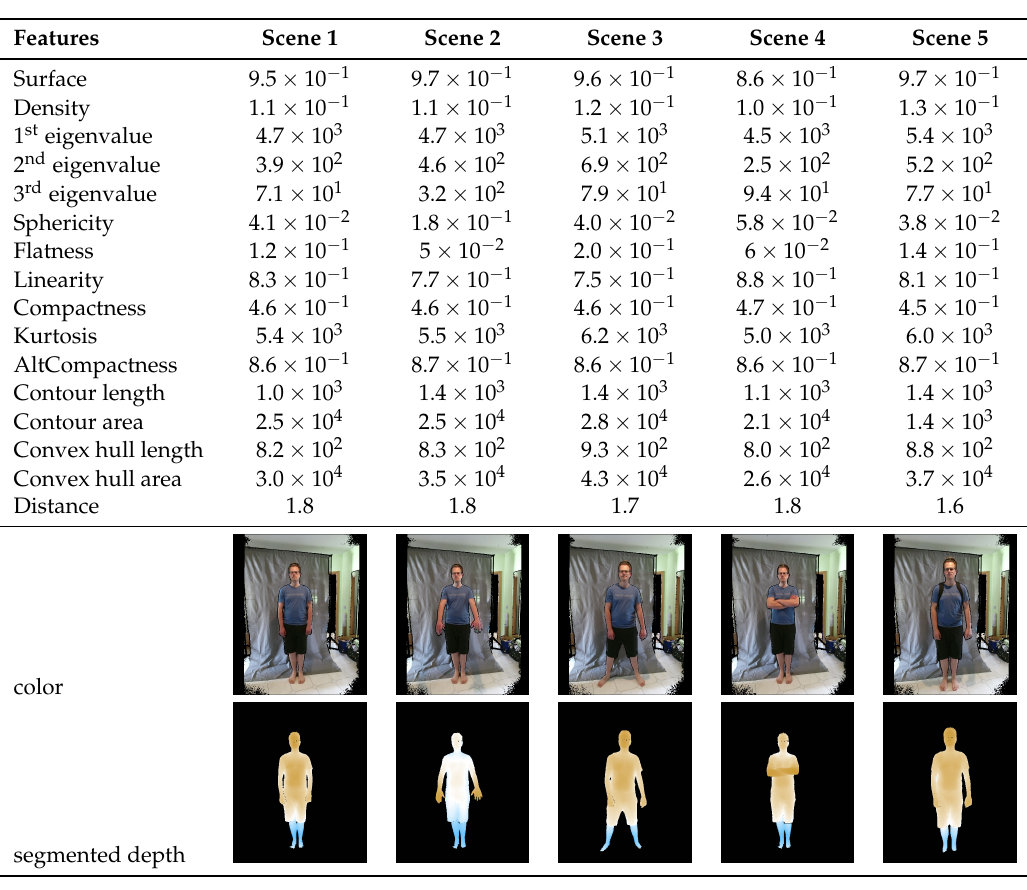
Table 5. Changes in features with different poses: Five different scenes illustrate the change in feature values depending on the